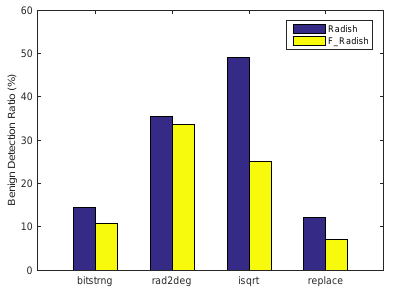
Figure 7. The benign detection ratios of F_Radish and Radish. (3)